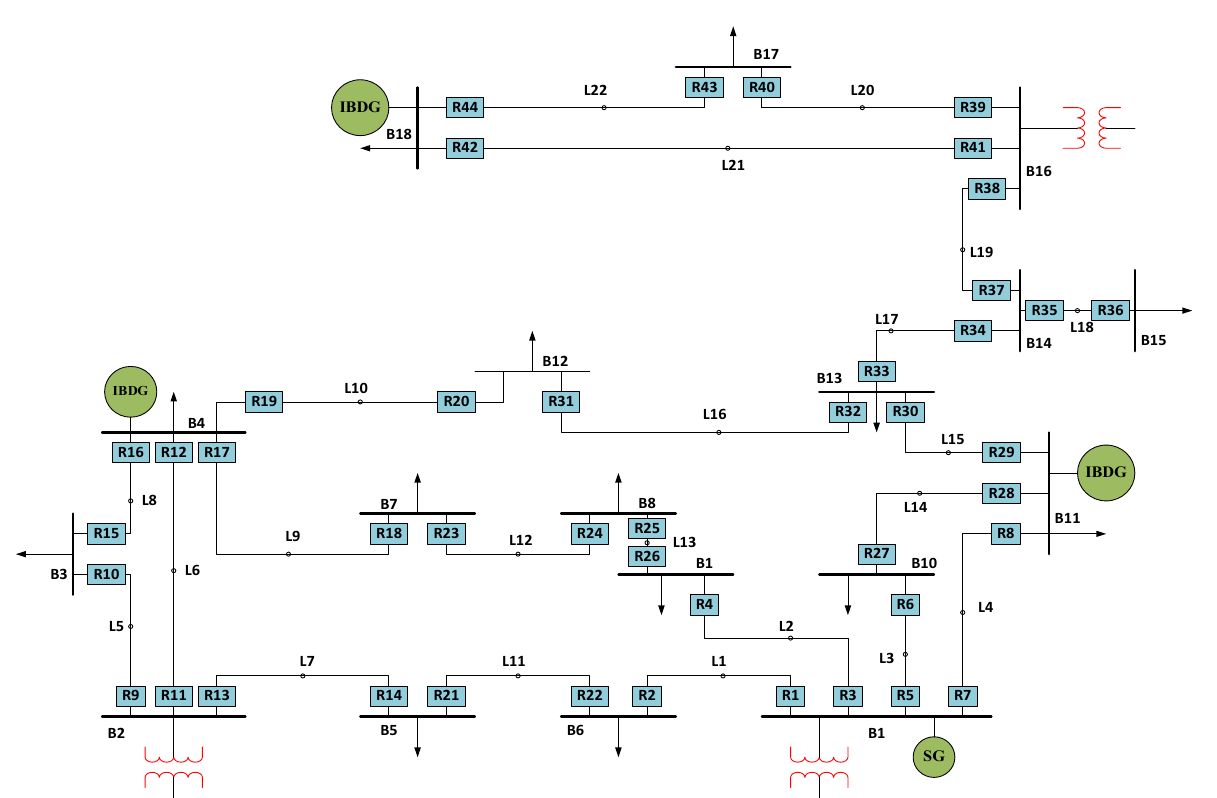
Fig. 11 Distribution part of IEEE-30 bus system (18-bus microgrid